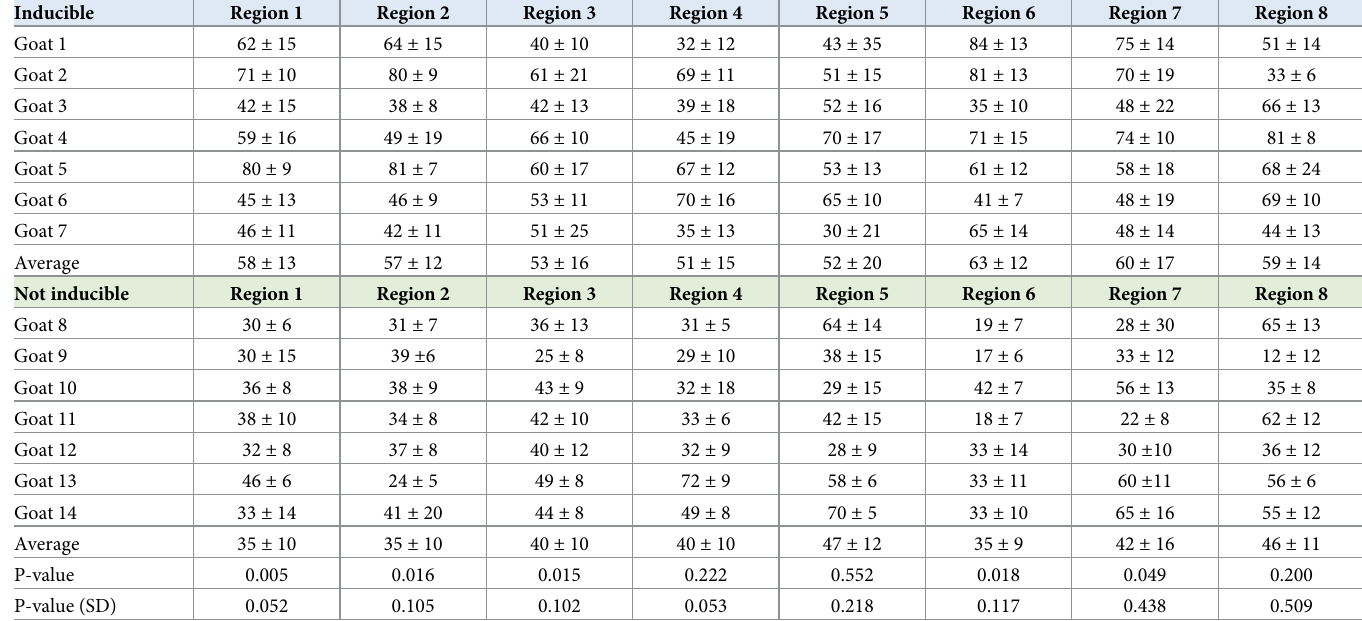
Table 2. Measured average Helix angles in 8 regions with vector 1 chosen as the reference vector for the two AF inducibility based animal groups. P-values showing the difference in the helix angles between the two AF inducibility-based groups in each region are also reported.